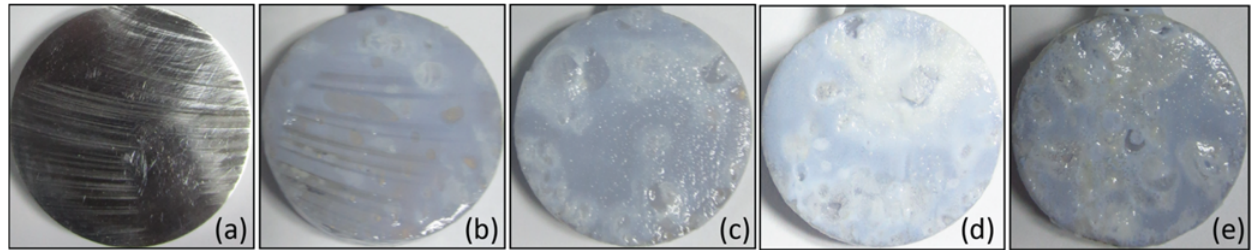
Figure 4. Specimens on removal from the synthetic seawater. ( a ) Reference (before testing); ( b ) 100 h; ( c ) 170 h; ( d ) 360 h; ( e ) 530